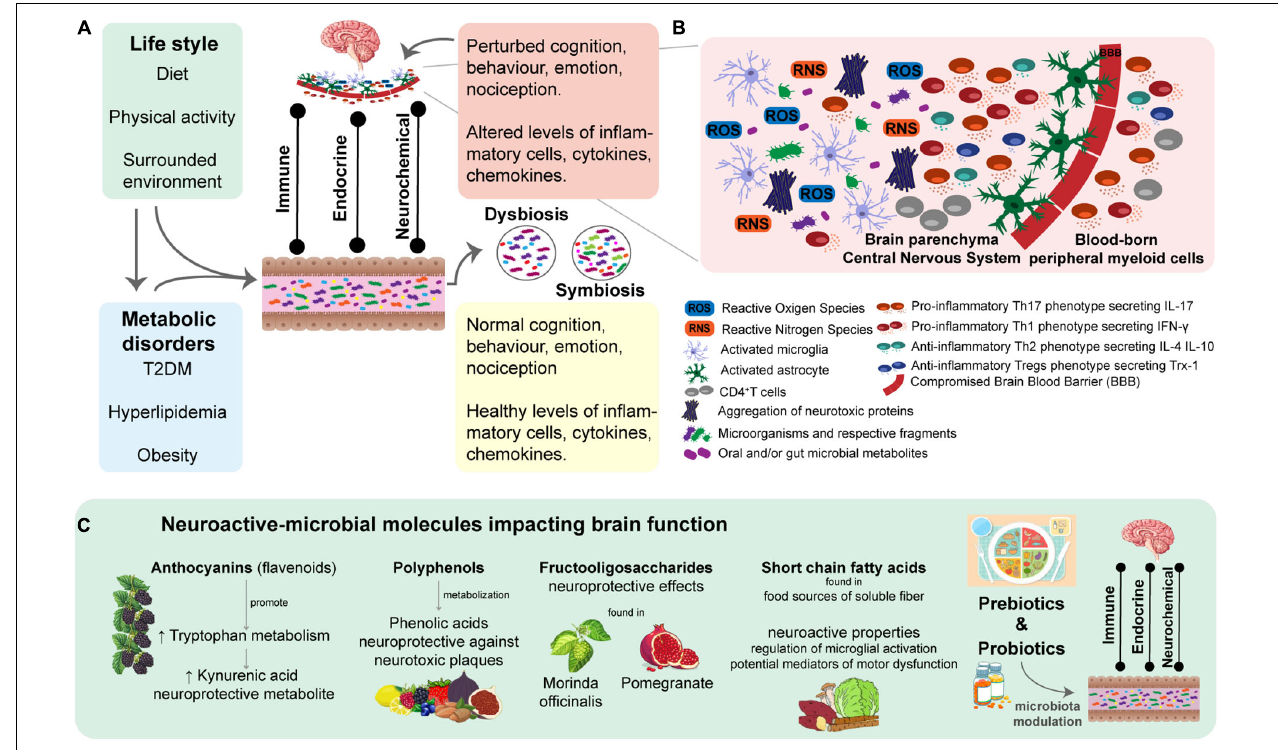
FIGURE 2 | Chronic neuroinflammation associated with disease-specific immune responses is a hallmark of Neurodegenerative diseases (NDDs). Thus, triggers of redox state imbalance and mechanisms promoting a proinflammatory brain response have been the target of therapeutic approaches. (A) An individual’s microbiota composition is strongly influenced by life style factors and personal clinical history. At the gut level, the intestinal microbiota plays an essential role in the modulation of the bidirectional gut-brain axis, through immune, endocrine and neurochemical direct and indirect pathways. There is evidence of symbiotic and dysbiotic gut microbiota assuming a preventive or promoter role in development and progression of NDDs, respectively. (B) Exacerbated neuroinflammation, due to chronic oxidative stress accompanied by dysregulated inflammatory response, is a Hallmark of NDDs. Increased levels of ROS and RNS stimulates the secretion of proinflammatory molecules (e.g., cytokines and chemokines), which in turn leads to microglia and astrocytes activation. Under these neuro-proinflammatory response, peripheral myeloid cells are recruited to the central nervous system (CNS), which intensifies microglia and astrocyte activation. Such a cascade of mechanisms is capable of perpetuating the proinflammatory response in the brain microenvironment, consequently loosing neuroinflammation regulation in NDDs. There are several mechanisms being studied that promote proinflammatory response, such as mitochondrial dysfunctions, aggregation of neurotoxic plaques, which can be stimulated by the invasion of microorganisms and respective fragments to the CNS, as well as by certain microbial metabolites with brain damaging profile. (C) Perturbation of the redox balance state and immune landscape healthy-state of the CNS of specific brain regions underlies disease-specific signatures of the neuroinflammatory microenvironment, which have been targeted in attempted therapeutic approaches. There is a list of studied neuroactive-microbial molecules improving brain function and cognition. These neuroprotective metabolites are microbially metabolized and secreted upon the ingestion of prebiotics.